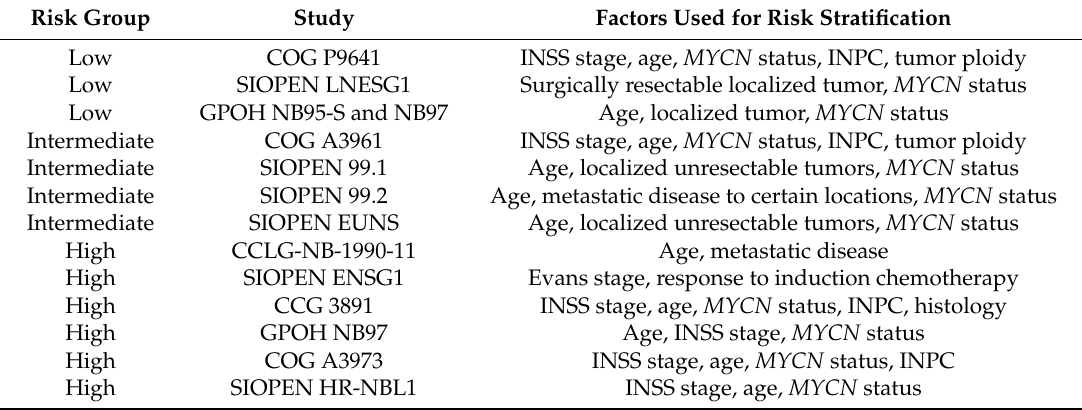
Table 4. Studies performed and the factors used for risk